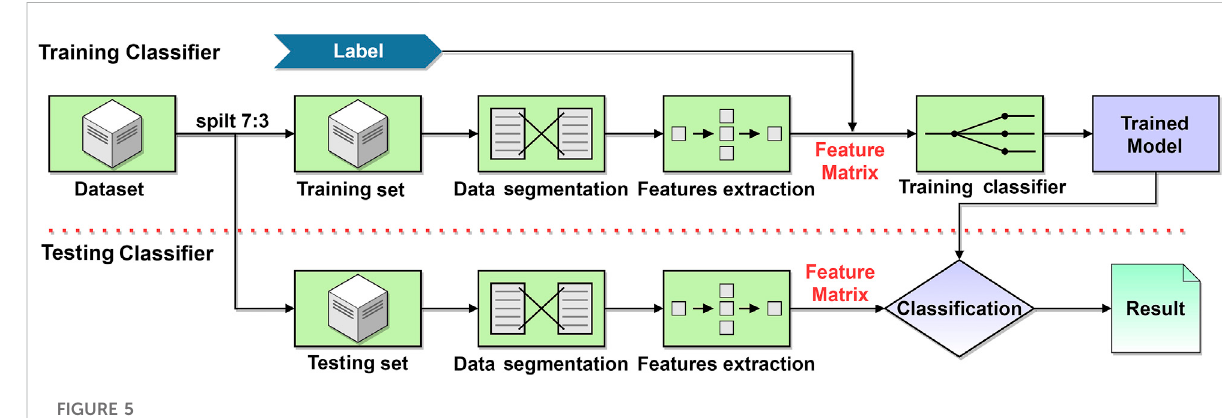
FIGURE 5 Flowchart of the microparticles classi fi cation based on machine